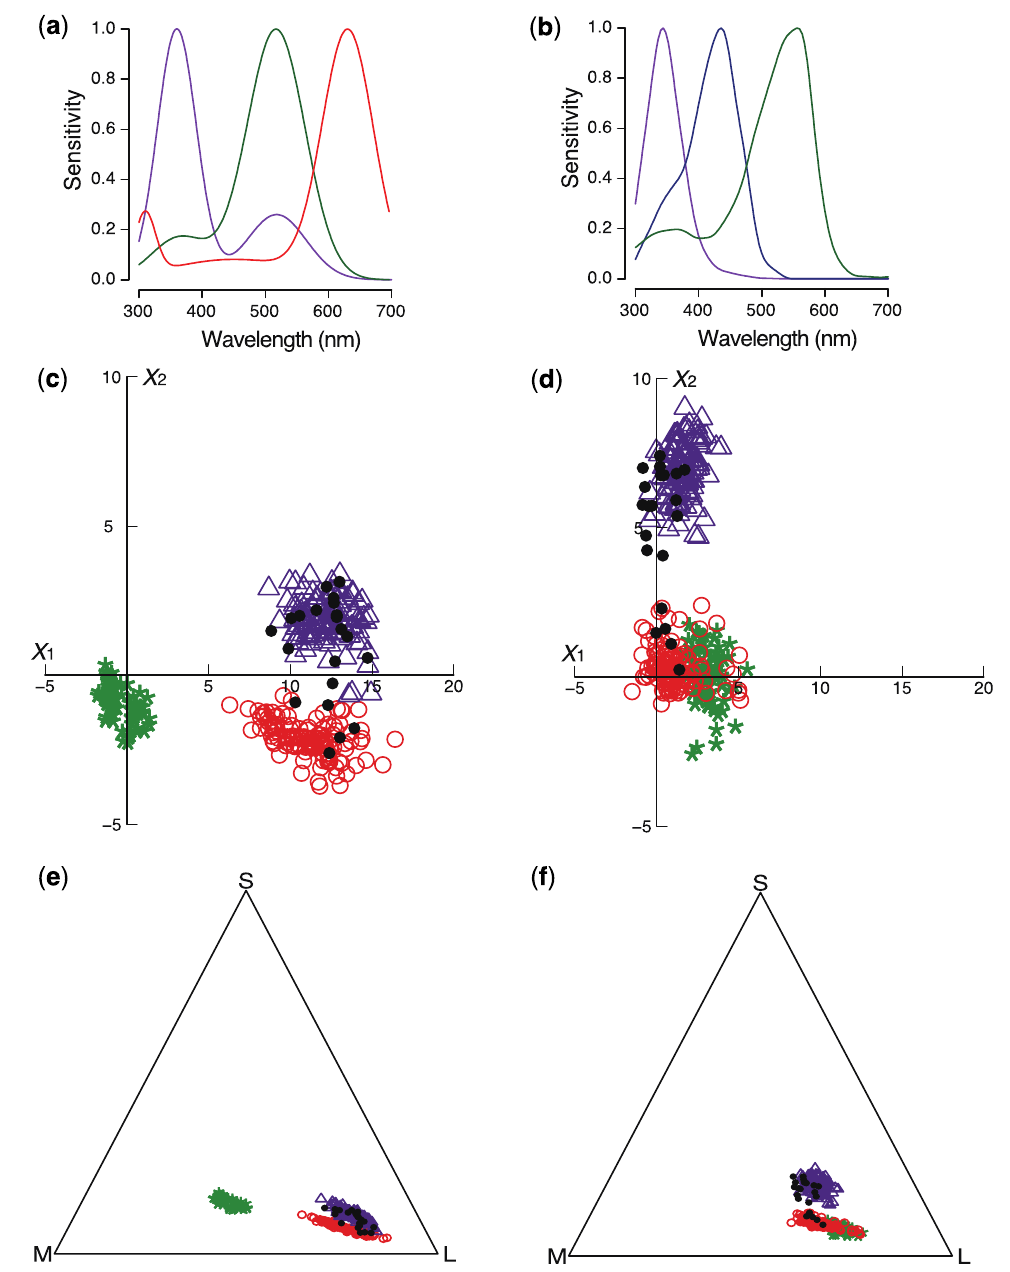
Figure 4. Modeling of flower color appearance for pollinators. ( a ) Spectral sensitivities of UV-, green-, and red-sensitive photoreceptors of Pygopleurus israelitus . ( b ) Spectral sensitivities of UV-, blue-, and green-sensitive photoreceptors of honeybees. ( c ) Colors of P. rhoeas represented in the chromaticity diagram of P. israelitus according to the receptor noise-limited (RNL) color-opponent model. ( d ) Colors of P. rhoeas represented in the chromaticity diagram of the honeybee according to the RNL color-opponent model. ( e ) Colors of P. rhoeas represented in the chromaticity diagram of P. israelitus according to the Maxwell triangle. ( f ) Colors of P. rhoeas represented in the chromaticity diagram of the honeybee according to the Maxwell triangle. The red circles represent the colors of negligibly UV-reflecting flowers from the East Mediterranean. The violet triangles represent the colors of flowers from Central Europe that reflect well in the UV. The black dots represent the colors of flowers collected in the North Mediterranean. The green asterisks represent the colors of green foliage.